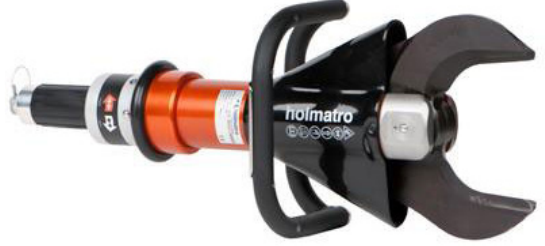
Figure 5. Holmatro hydraulic cutters, model CU 3035 NCT [36]. Table 1. Technical parameters Holmatro, CU 3035 NCT